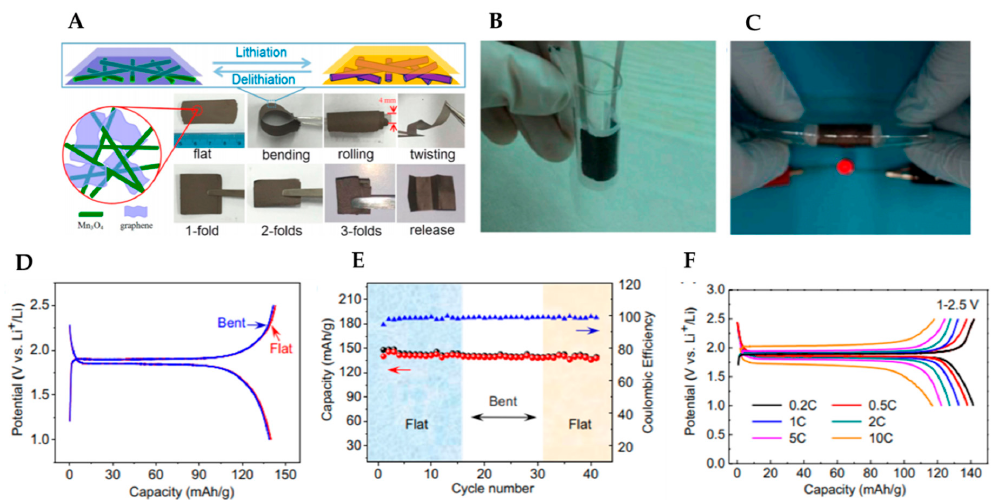
Figure 1. ( A ) Schematic (top view and cross-sectional view) of rGO / Mn3O4 membrane and its digital photographs illustrating the flexibility (bending, rolling, and twisting) and foldability (1, 2, and 3 folds) states. Adapted with permission from [27]. Copyright (2014) Advanced Materials . Characterization of a thin, lightweight, and flexible LTO / GF or LFP / GF full battery. ( B ) Photograph of a bent battery encapsulated by PDMS, exhibiting good flexibility. ( C ) Lighting a red LED device at a bent state. ( D ) Galvanostatic charging / discharging curves of battery. Red and blue lines represent the as-fabricated flat battery and bent battery after 20 times of repeated bending at a 5-mm radius, respectively. ( E ) Cyclic performance of the battery in flat and bent states. ( F ) Charging–discharging voltage curves of battery with di ff erent current rates. Adapted with permission from [28]. Copyright (2012) Proceedings of the National Academy of